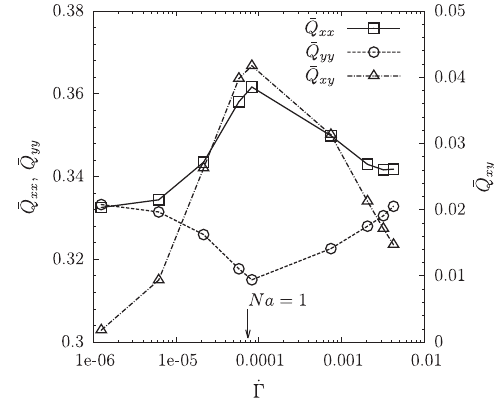
FIG. 5. The spatial average of the bond-orientation tensor of the ¯ Q polymer chains αβ as a function of the gross shear rate addition, see the caption in Fig. 4.